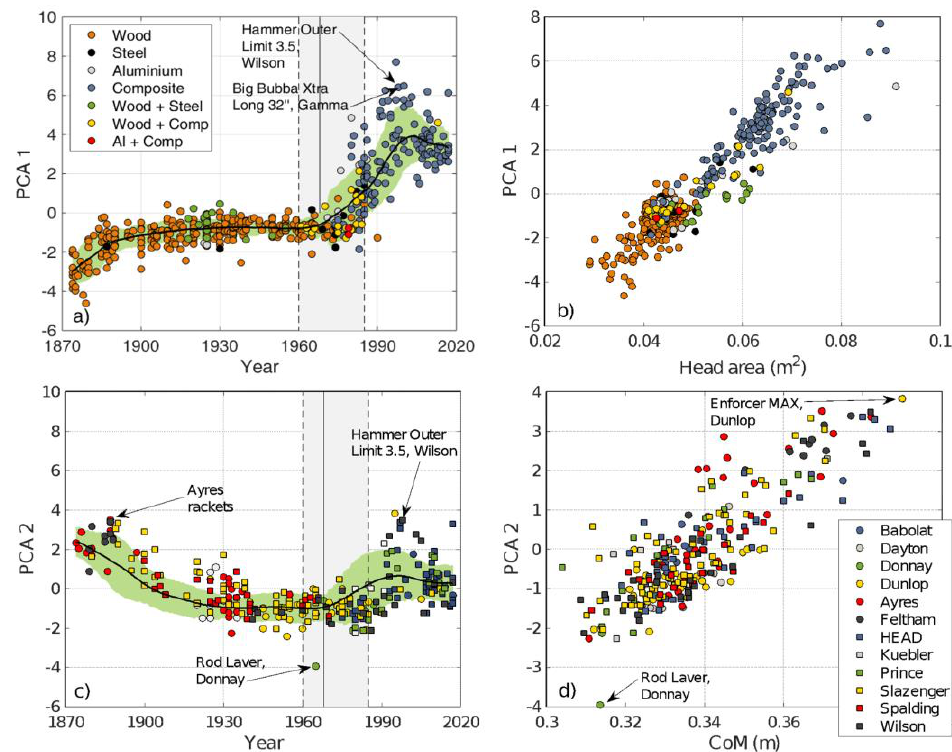
Figure 8. Results of PCA: ( a ) PCA1 vs. year, showing materials; ( b ) PCA 1 vs. head area, showing materials; ( c ) PCA2 vs. year, showing brands; ( d ) PCA 2 vs. CoM location, showing brands.